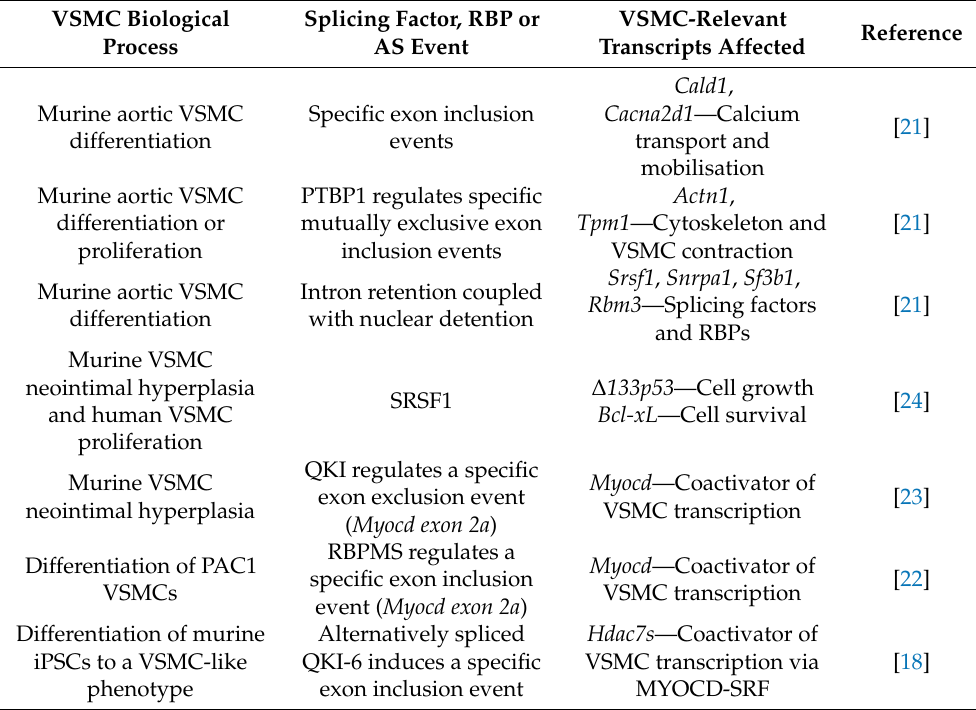
Table 1. Summary of primary regulators and outcomes of alternative splicing in vascular smooth muscle cell